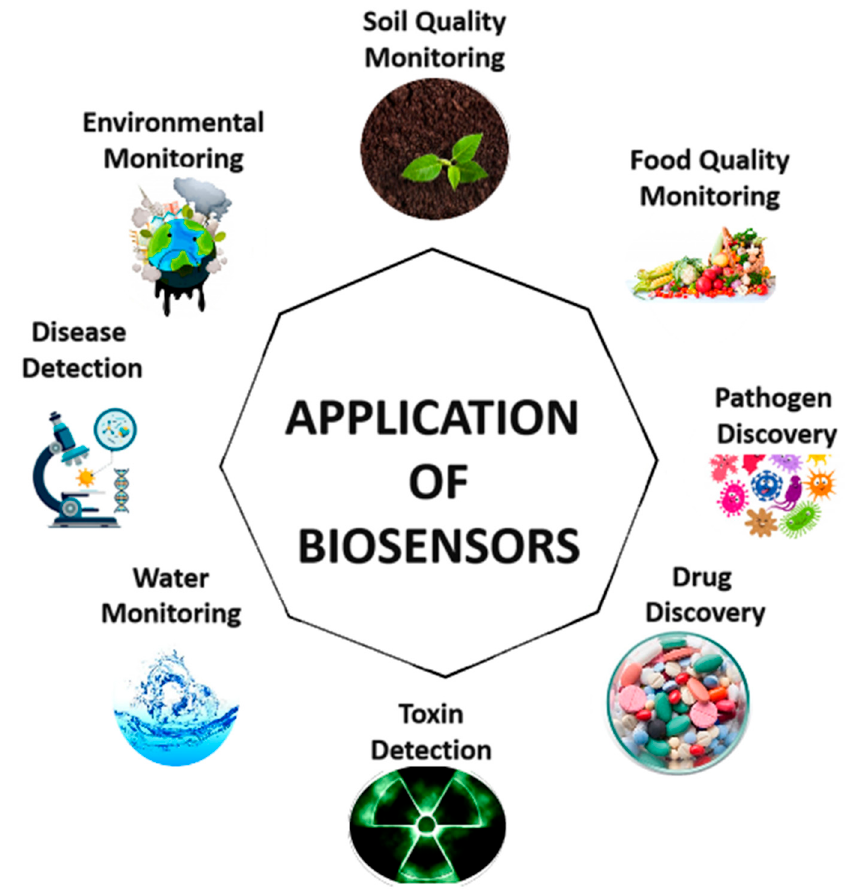
Figure 4. Application of Biosensors .